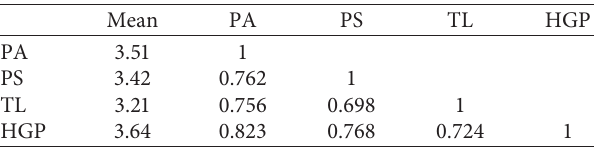
Table 2: Pearson correlations among the study’s continuous